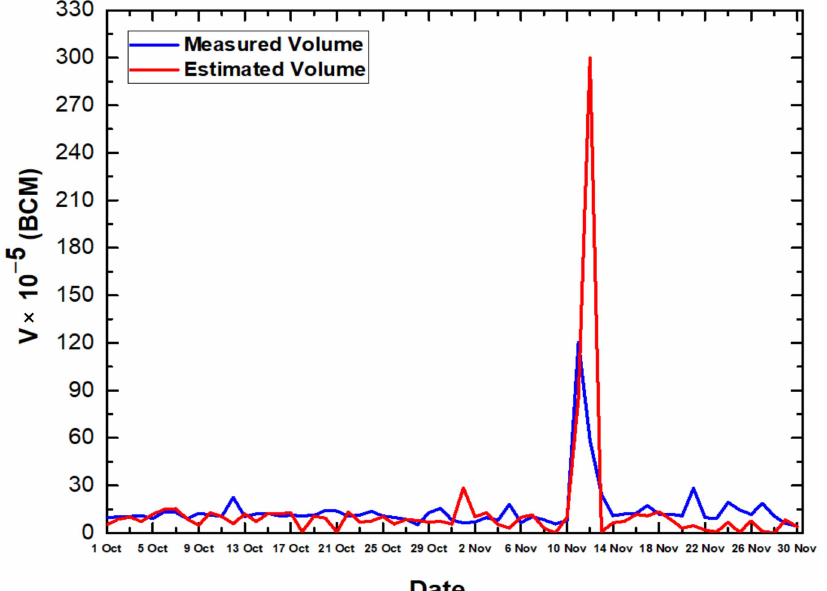
Figure 11. Values of “daily” (October and November 2021) flared gas volumes, provided by the SONATRACH and those estimated by the proposed unmixing-approach combined with the used “third-order” regression model applied on the provided “hourly” in situ